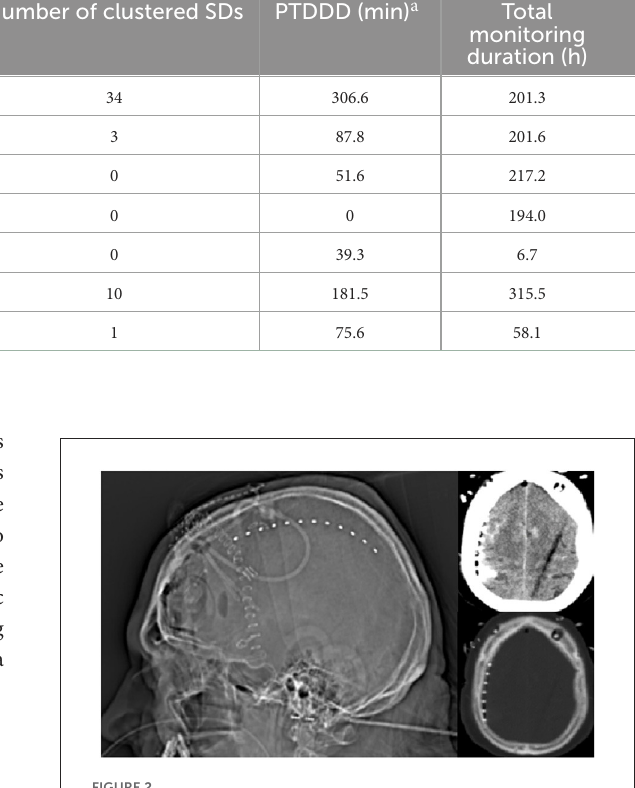
FIGURE2 Electrode localization on imaging. Localization of the Spencer-type depth electrode (12 contact electrode) after implantation via a burr